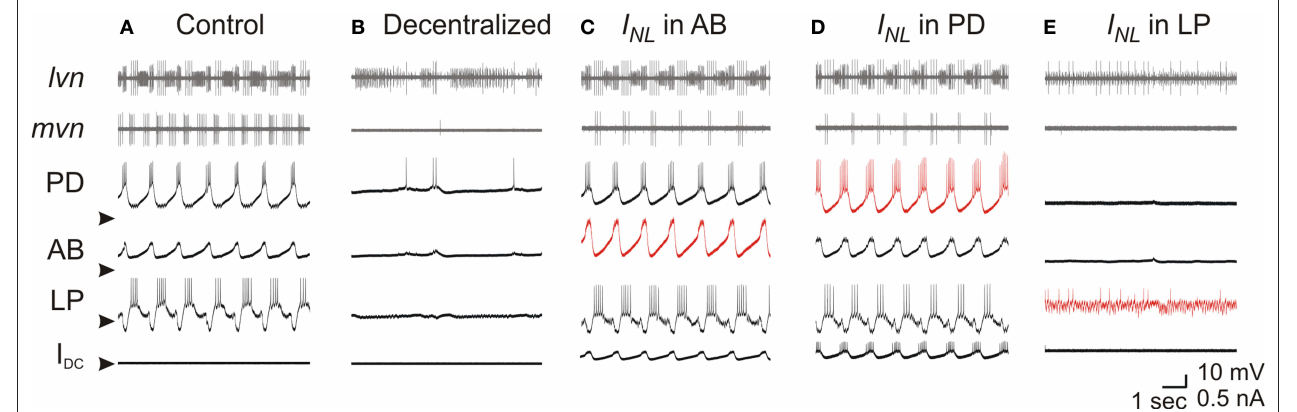
Figure  | effect of negative leak conductance on pyloric network activity. Simultaneous recordings of lvn and mvn (extracellular), and of PD, AB and LP neurons (intracellular) are shown in all panels. Bottom traces show the current injected with dynamic clamp ( I ) in the respective neuron. (A) Control pyloric DC activity before decentralization. (B) Lack of rhythmic activity after decentralization.